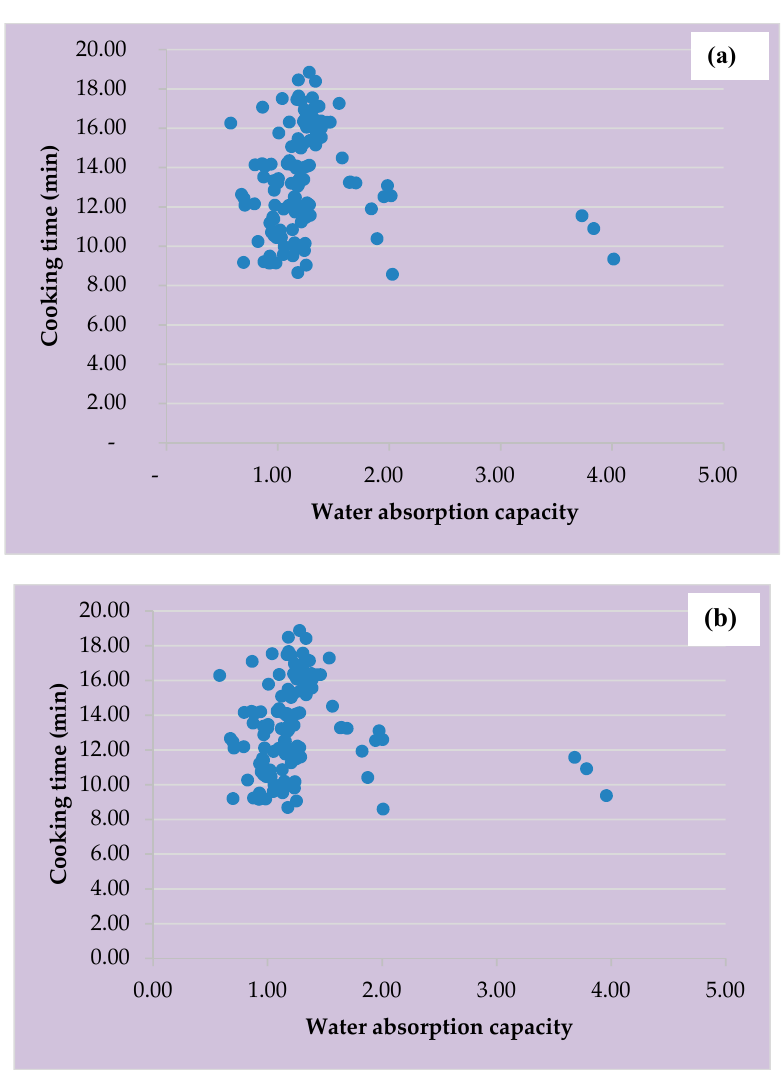
Figure 2. Correlation between water absorption and cooking time for the three checks. ( a ) Plotted with data from Site A; ( b ) plotted with data from Site B.